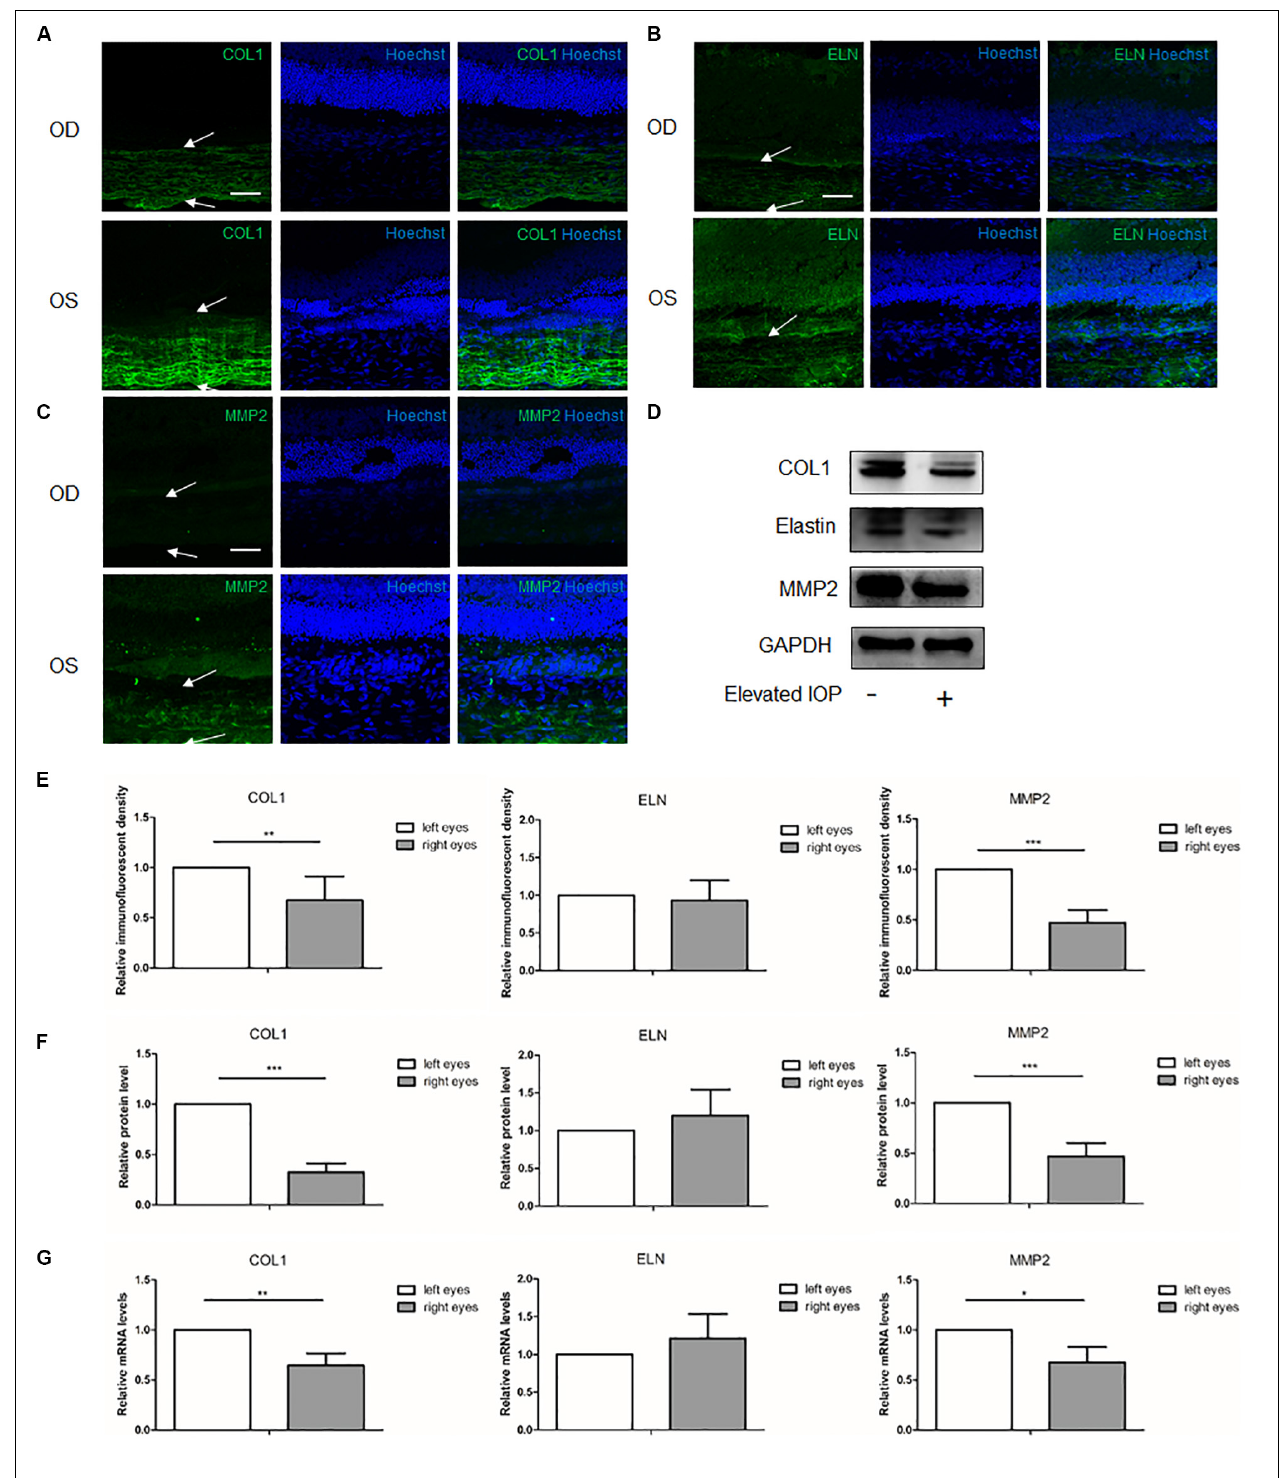
FIGURE 4 | Expressions of the scleral extracellular matrix (ECM) components under chronic elevated intraocular pressure (IOP) for 4 weeks. The ocular hypertension model was established for 4 weeks in rats. Immunohistochemical staining showed the scleral (A) collagen I ( green ), (B) elastin ( green ), and (C) matrix metalloproteinase 2 (MMP2, green ) expressions in the hypertensive right eyes ( OD ) and the contralateral left eyes ( OS ). White arrows indicate the sclera. Scale bar , 50 µ m. (E) Semi-quantitative analysis of the immunofluorescent images ( n = 5). (D) Western blot and (F) the quantification analysis showed the protein expressions of collagen I, elastin, and MMP2 ( n = 8). (G) mRNA levels of collagen I, elastin, and MMP2 ( n = 6). GAPDH was set as the loading control. Data were expressed as the mean ± SD of three replicates. * P < 0.05; **0.001 < P < 0.01; and *** P < 0.001.